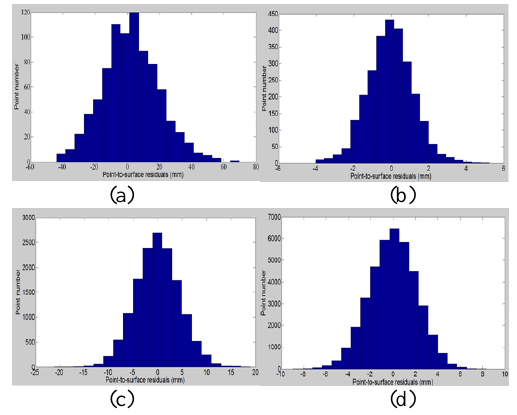
Figure 4. The histograms of point-to-surface residuals of the fitted surfaces. (a) Dataset A; (b) Dataset B1; (c) Dataset C1; (d) Dataset 2